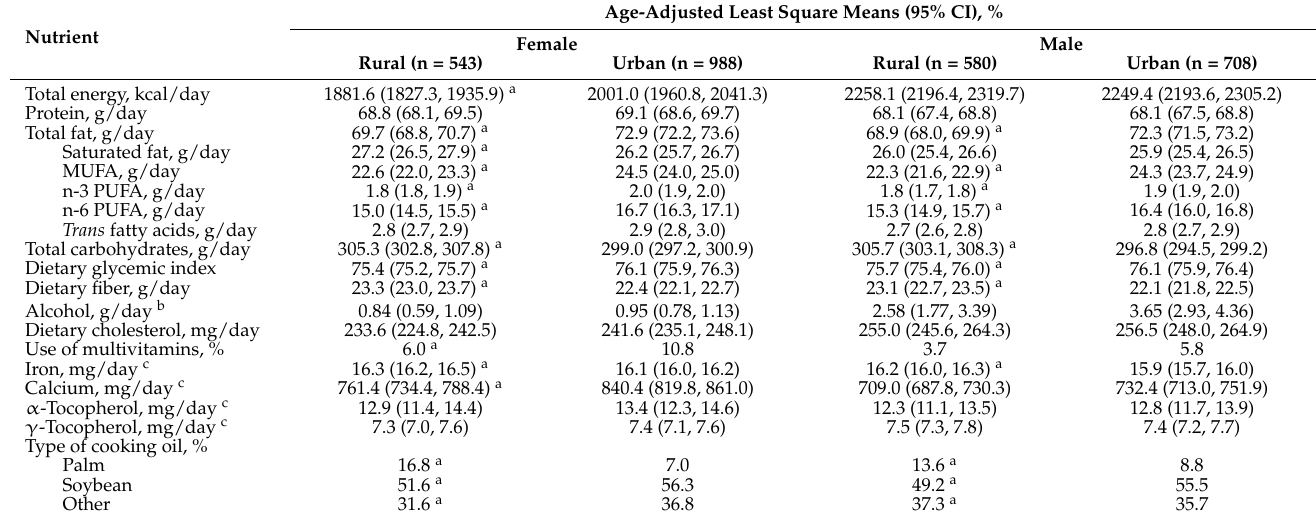
Table 3. Sex-stratified comparison of total energy-adjusted macronutrient intakes and type of cooking oil used in rural and urban